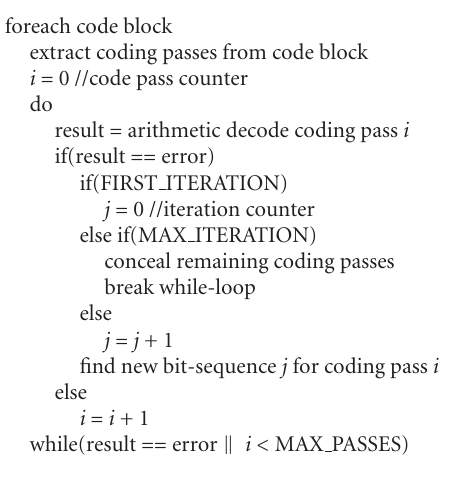
Algorithm 1: Pseudocode for a general iterative decoding algo-